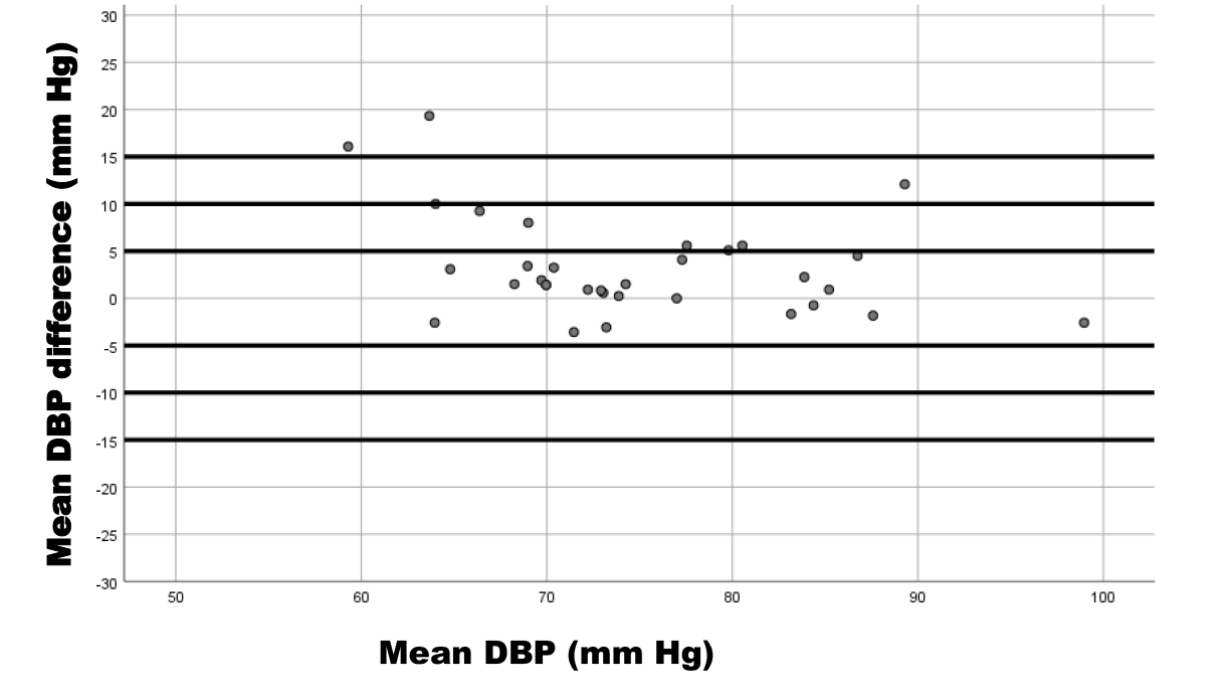
Figure 4. Bland-Altman plot of diastolic blood pressure (DBP) measurement differences between the iHealth Track (test) and the Omron M3 (reference) devices in 33 participants. Mean DBP difference is the diastolic difference between the devices; mean DBP is the mean diastolic average values of the devices.